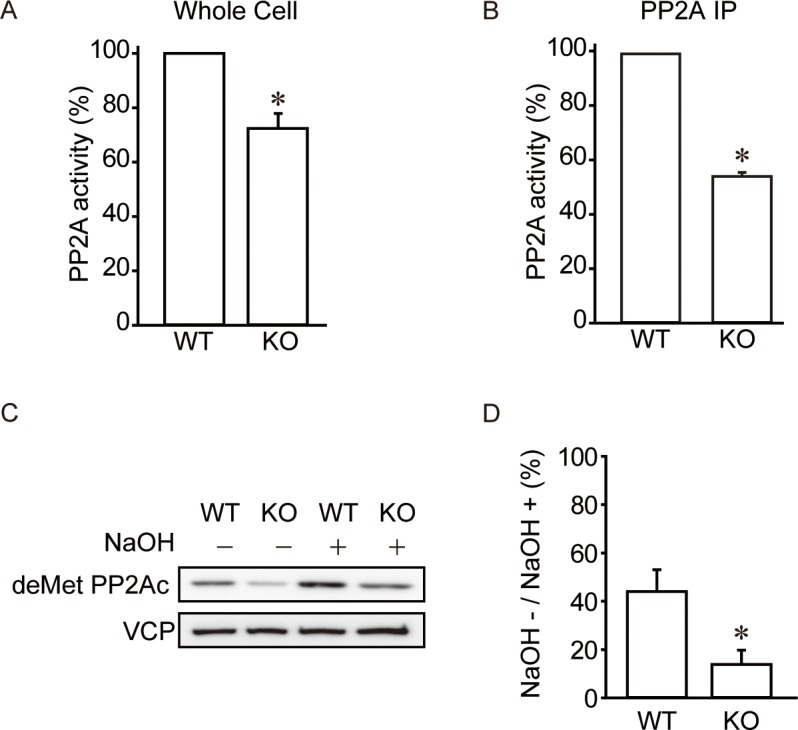
PME-1 knockout reduces whole cell PP2A activity.(A) Loss of PME-1 suppresses whole cell PP2A activity. PP2A phosphatase activity was analyzed with phospho-peptides as a substrate and calculated as difference between samples ± 10 nM okadaic acid. N = 4. *: P<0.05 vs. WT. (B) Loss of PME-1 suppresses PP2A specific activity. PP2A specific phosphatase activity was analyzed with immunoprecipitation based PP2A activity assay. N = 4. *: P<0.05 vs. WT. (C-D) Loss of PME-1 enhances PP2Ac methylation. Cell lysates were treated with or without NaOH. The ratio of demethylated PP2Ac was determined by immunoblotting for demethylated PP2Ac (deMet PP2Ac). Representative picture (C) and quantitative data (D) from 3 independent experiments are shown. *: P<0.05 vs. WT.